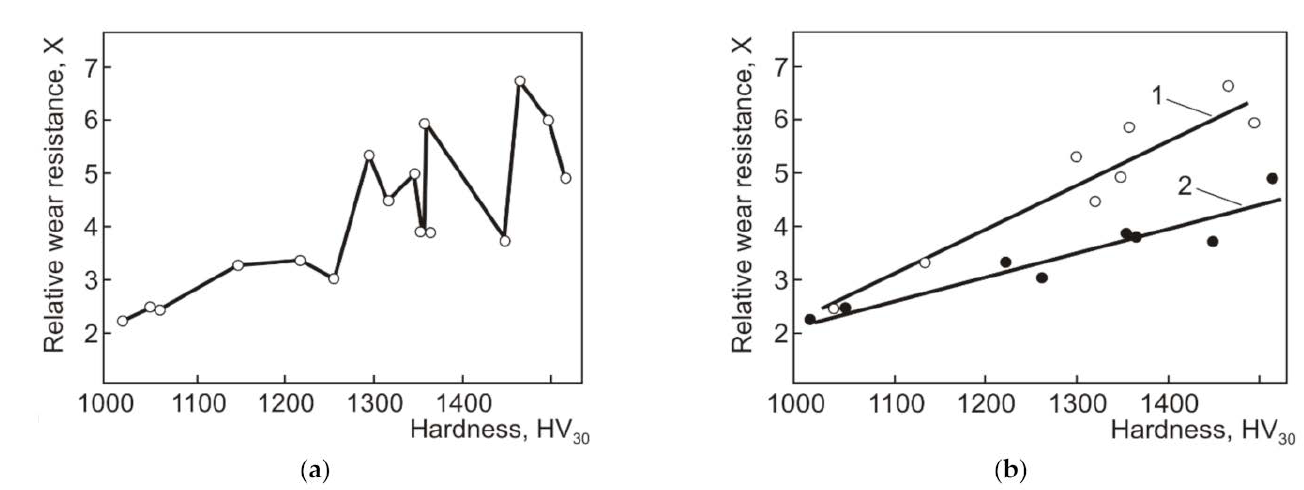
Figure 13. Relative erosive wear resistance vs. hardness of TiC-based cermets with different vol% carbides and composition, structure and properties of the binder: ( a )–all cermets; ( b ) cermets with distinguished binder families, 1—martensitic steel binder, 2—austenitic steel binder and Ni:Mo (4:1) binder (abrasive SiO 2 , impact velocity 80 m/s, attack angle α = 30 ◦ ) [34].